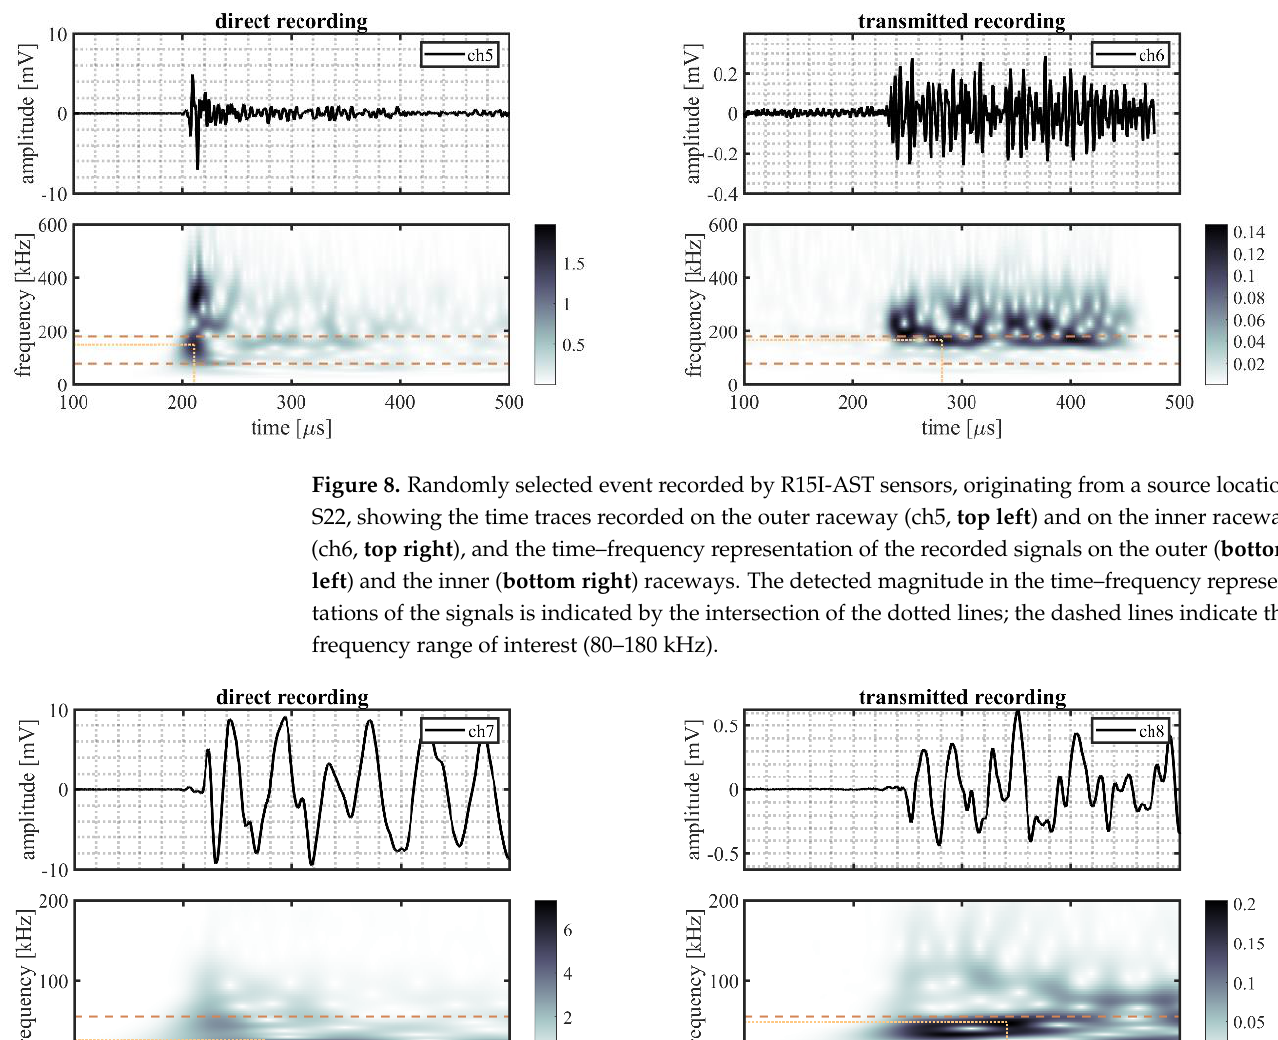
Figure 10. Randomly selected event recorded by R6I-AST sensors, originating from a source location S22, showing the time traces recorded on the outer raceway (ch9, top left ) and on the inner raceway (ch10, top right ), and the time – frequency representation of the recorded signals on the outer ( bot- tom left ) and the inner ( bottom right ) raceways. The detected magnitude in the time – frequency